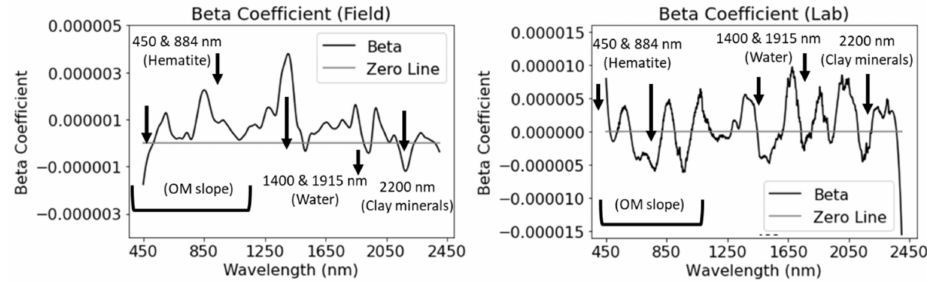
Figure 7. Beta coefficients of the PLSR models for the prediction of WIR using all samples and the ASD spectral